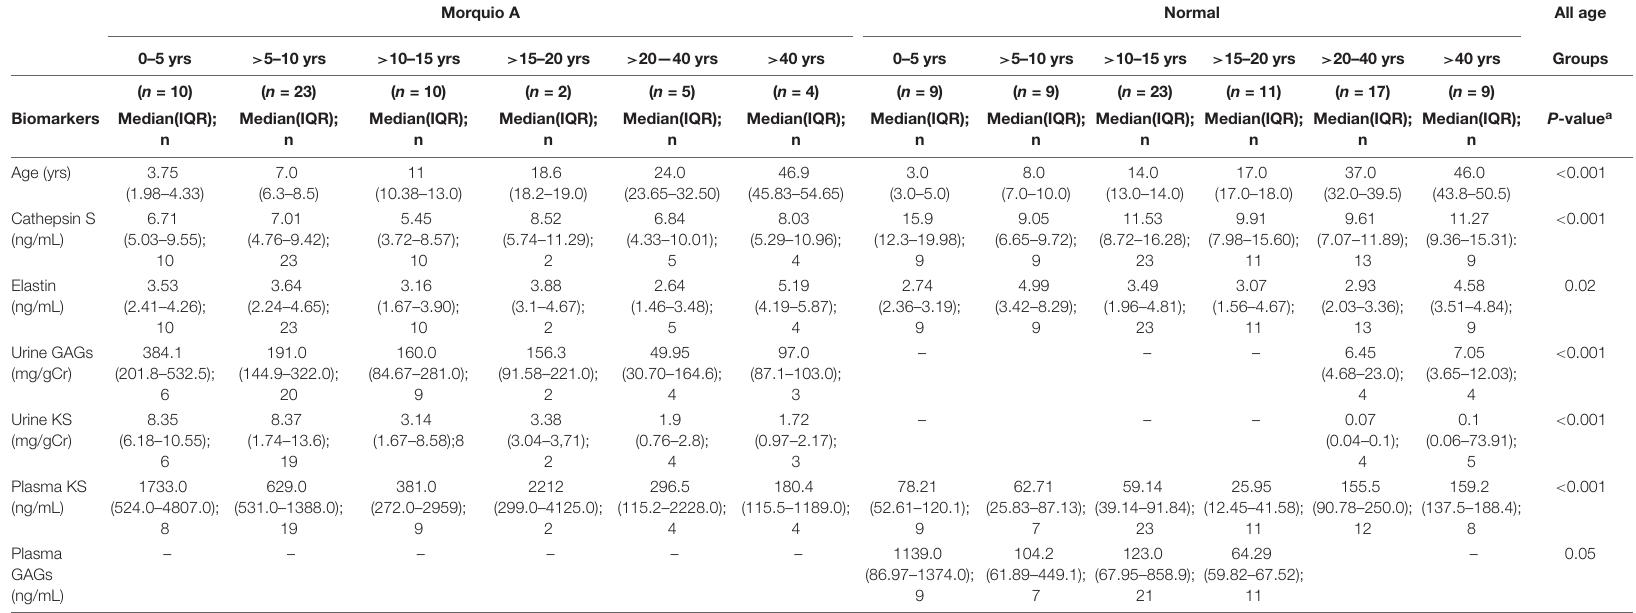
TABLE 2 | Biomarker comparisons of Morquio A and normal control age